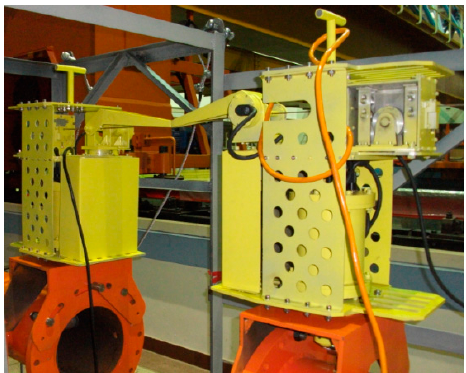
Figure 3. Initialization of the measuring device.